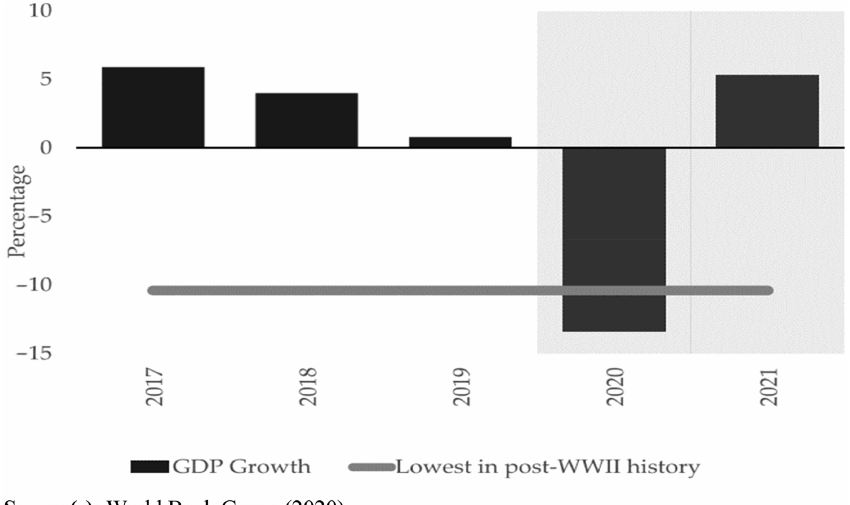
Figure 6. Global trade